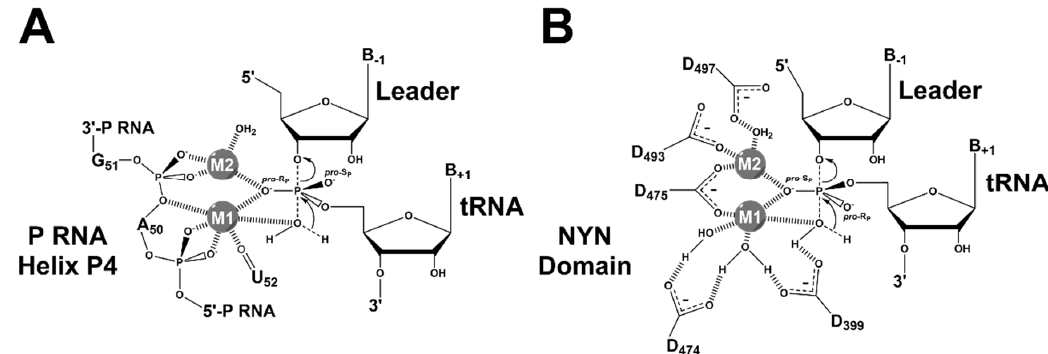
Figure 8. Proposed transition state structure of the catalytic mechanisms of ( A ) bacterial RNase P (as proposed in [22]) and ( B ) At PRORP1 (adapted from [110]).